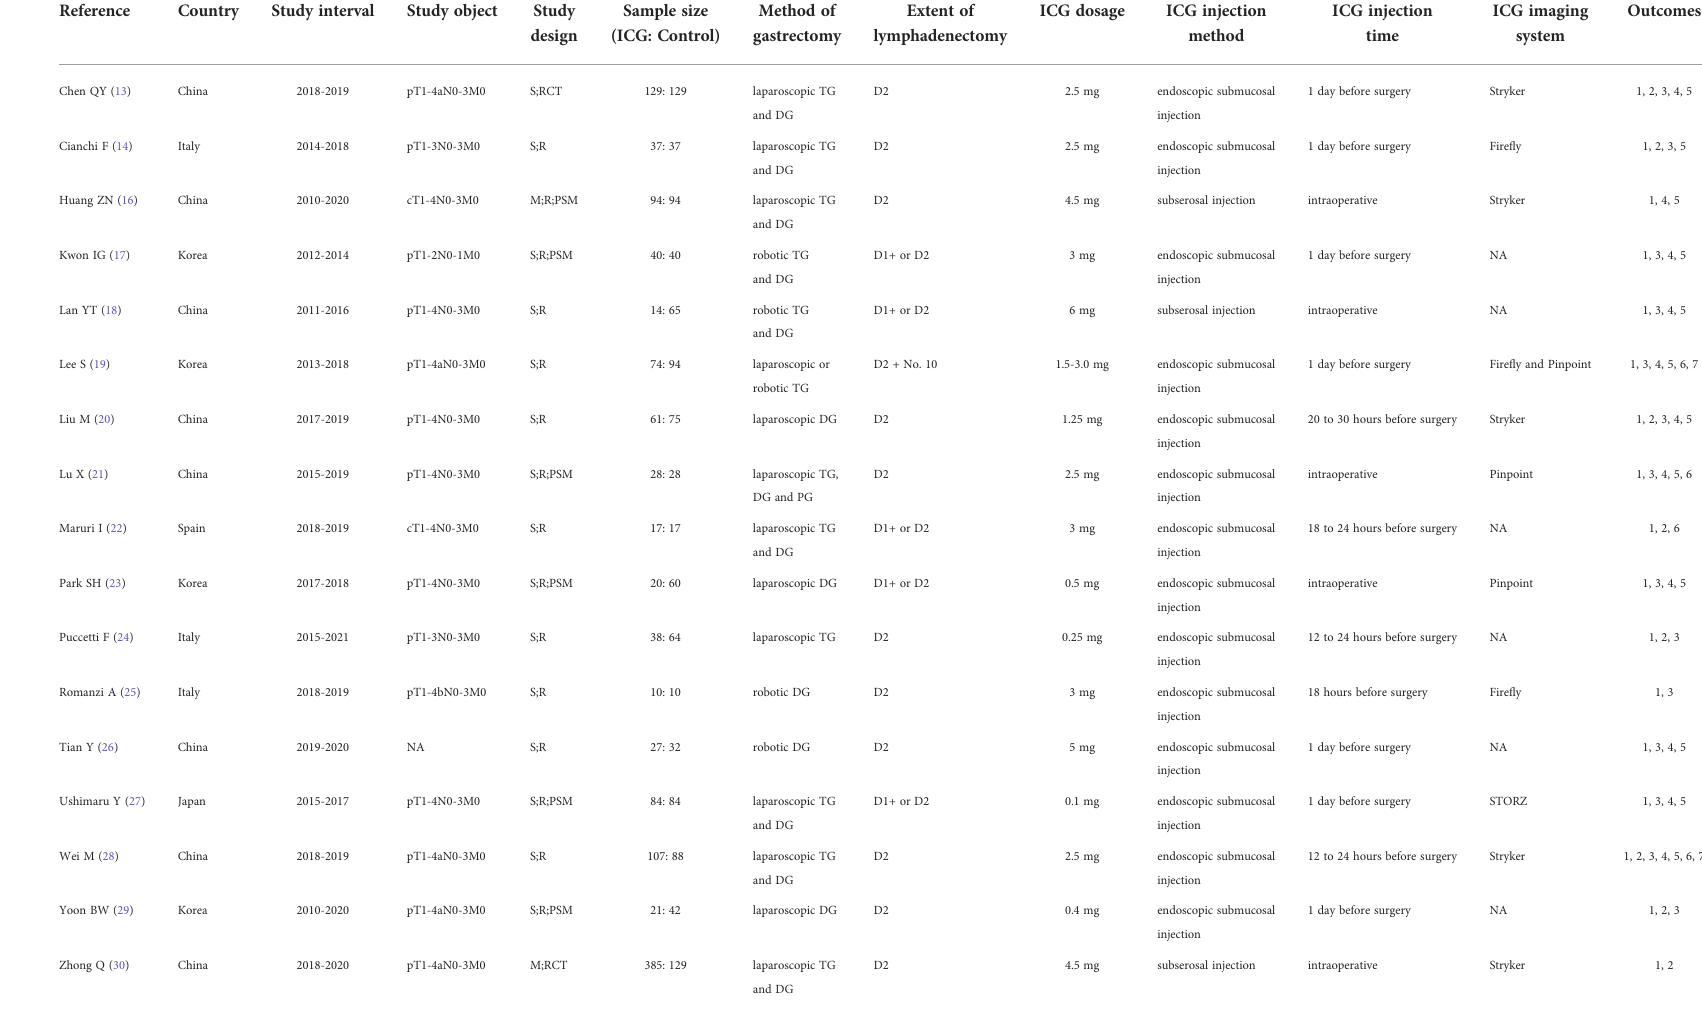
TABLE 1 Characteristics of studies. Reference